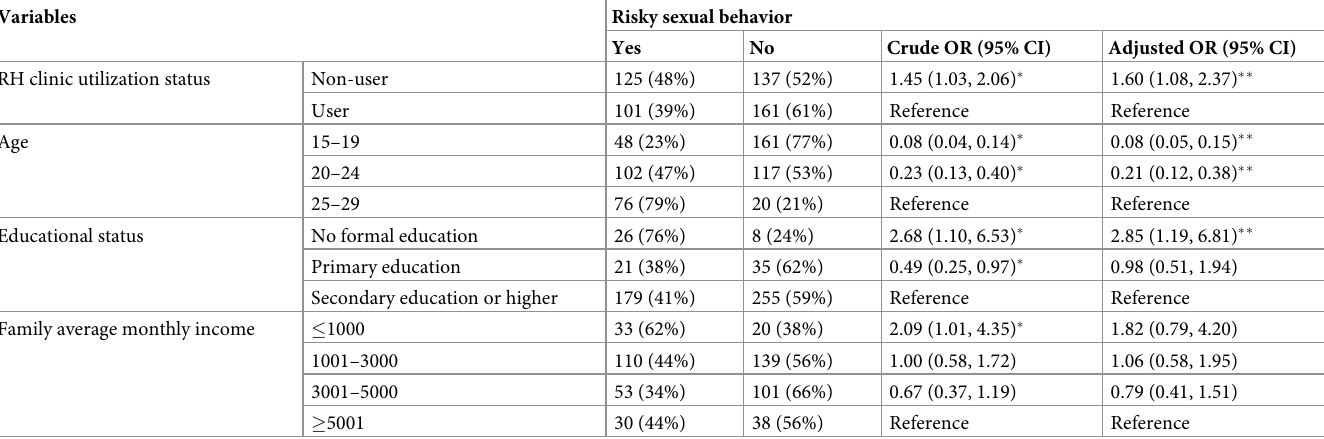
Table 5. Bivariate and multivariable logistic regression analysis of risky sexual behaviors among youth in Addis Ababa, Ethiopia, 2016.